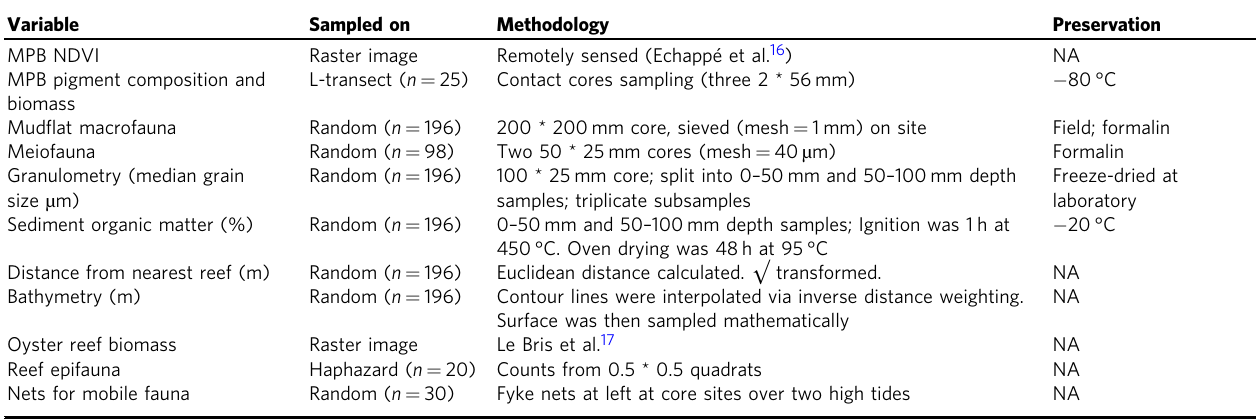
Table 3 Summary of study variables and their sampling